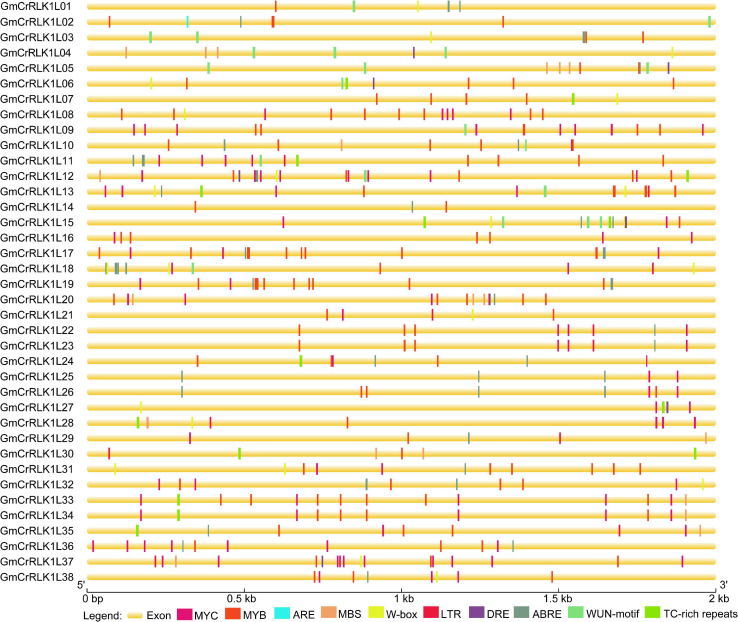
Predicted cis-elements in soybean CrRLK1L gene promoter’s region. Different cis-elements are marked by distinct color blocks and are located in relative positions on the promoter. The ABA-responsive element (ABRE), anaerobic induction element (ARE), low-temperature responsiveness element (LTR), defense and stresses responsiveness element (TC-rich repeats), wound-responsive element (WUN-motif), MYB binding site involved in drought-inducibility (MBS), W-Box, MYB, MYC, and DRE were analyzed. The upstream length to the translation starts site can be obtained using the scale at the bottom.